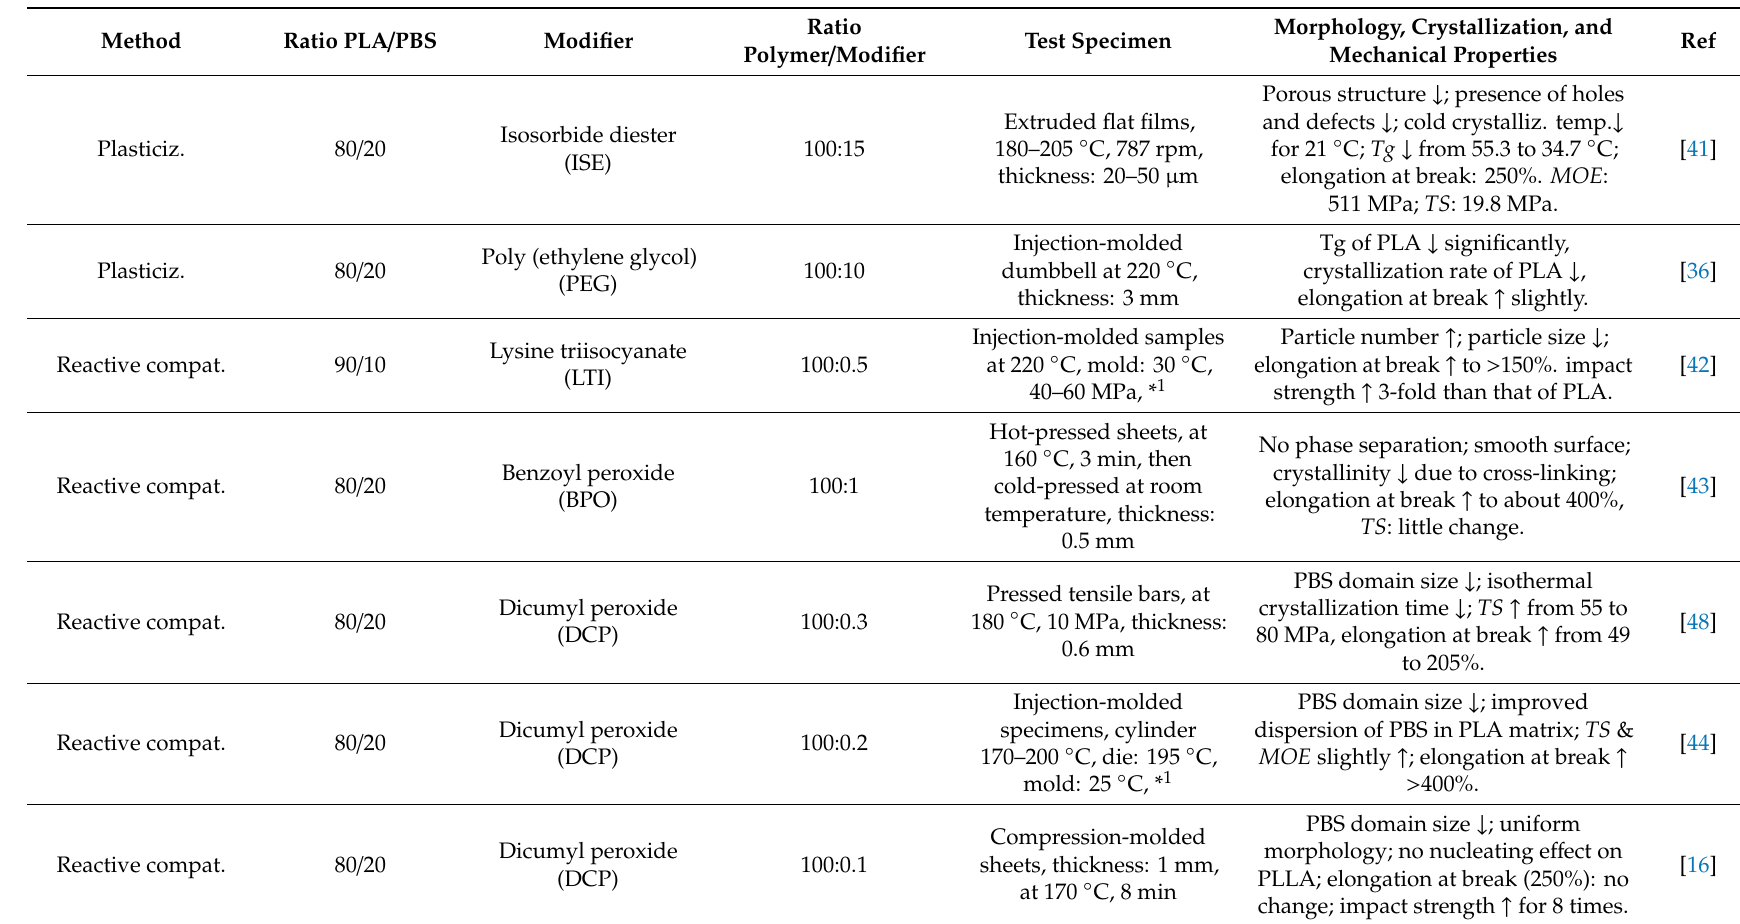
Table 2. Toughness